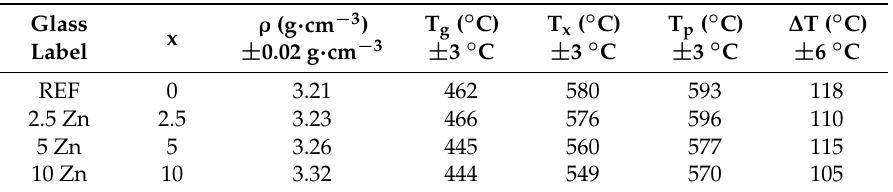
Table 1. Physical and thermal properties of the glasses.